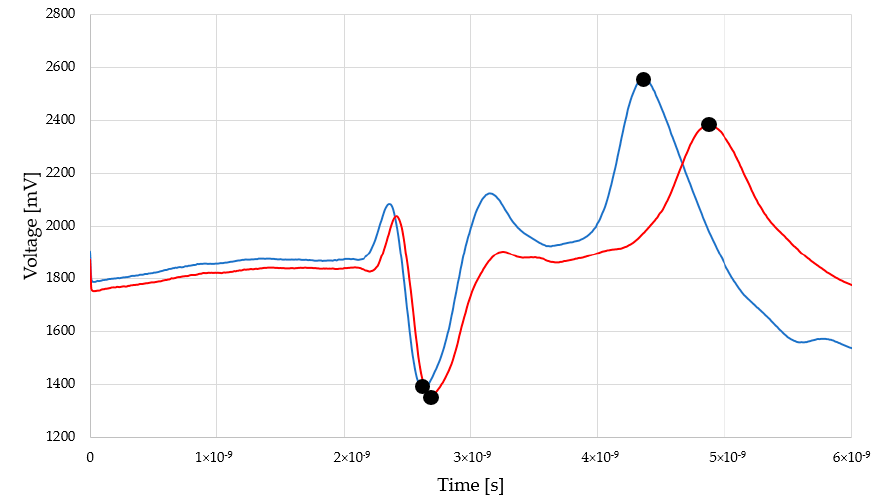
Figure 5. Reflectograms achieved by Sensor B for dry and moist material. The peaks indicated by black dots are markers for electromagnetic pulse travel along the waveguides touching the examined material. In both figures, the first, negative one shows the entrance to the sensor (built-in resistor) and the second (positive) one, sensor termination. The position of this second peak is significant for relative permittivity eval- uation. In the case of dry material (blue line), the second position is located closer to the first, negative peak. In the case of moist material (red line), second peak is located further. Within the measurement, a set of the TDR waveforms was collected and the distances between markers were recalculated into the relative permittivity values according to the Equation (2). Figures 6 and 7 present the recalculated times of signal propagation into relative permittivity values for different material humidity, showing the relations between red brick mass moisture and relative permittivity values, whereas dashed lines mean confidence intervals. Red dots represent the mean values of the five relative permittivity readouts for each material moisture